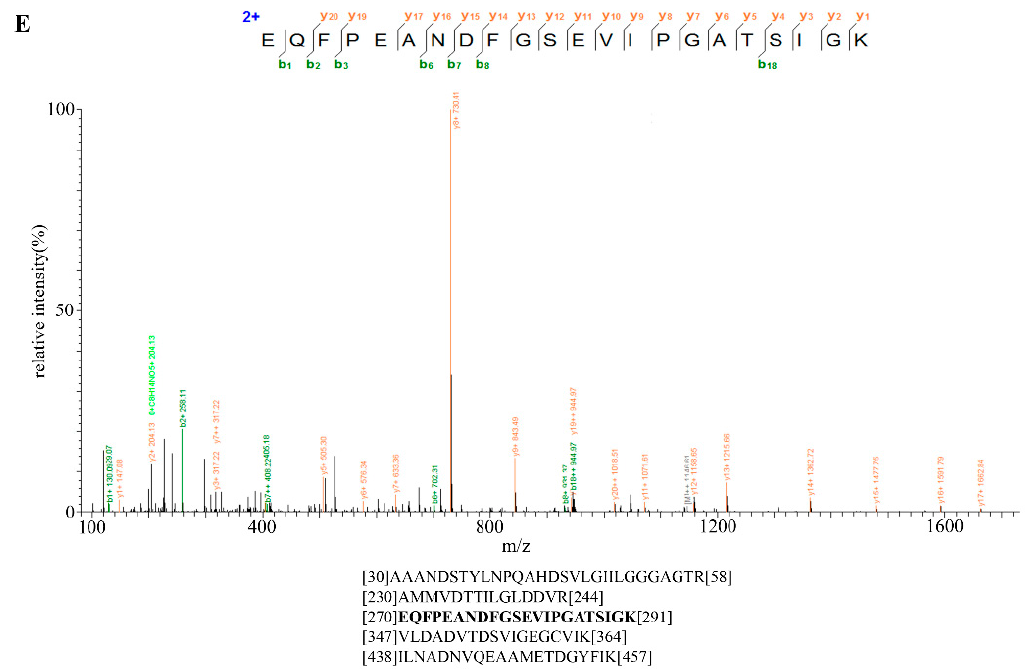
Figure 1. The proteomic analysis of maize endosperm proteins enriched by phos-tag TM agarose. ( A ) Summary of peptides and proteins identified. ( B ) Gene ontology analysis of molecular function level. ( C ) Gene ontology analysis of biological process level. ( D ) Gene ontology analysis of cellular component level. Percentages shown indicated GO term protein accounted for total protein number. ( E ) The representative mass spectrometry diagram and peptides of Bt2 protein. The mass spectrometry diagram shows the bold type of peptide. The numbers show the position of amino acid in Bt2 protein.